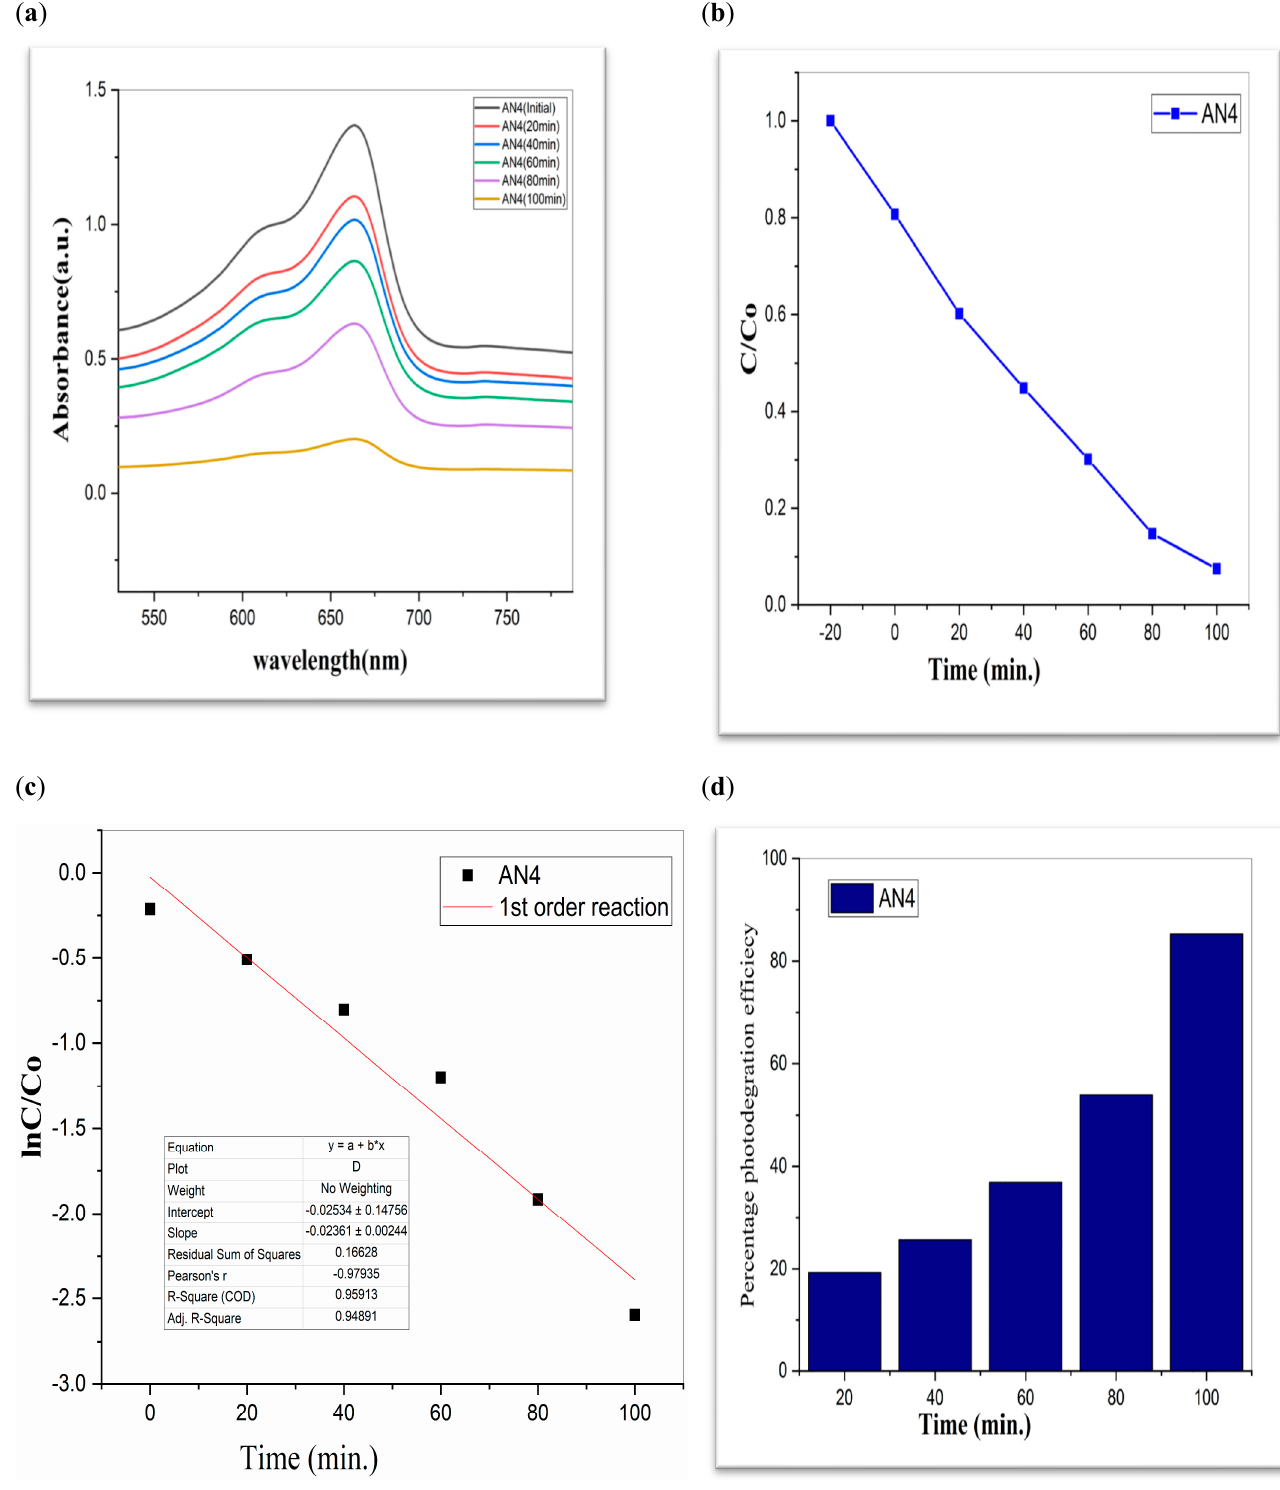
Figure 8. AN4 ( a ) graphical representation of degradation of methylene blue; ( b ) C/C 0 ; ( c ) lnC/C 0 ; ( d ) %age e ffi ciency. The photocatalytic activity of CdS/MoS 2 /Bi 2 S 3 nanoparticles for dye degradation was tested utilizing extended UV irradiation. The photocatalytic activity of “CdS/MoS 2 /Bi 2 S 3 ”